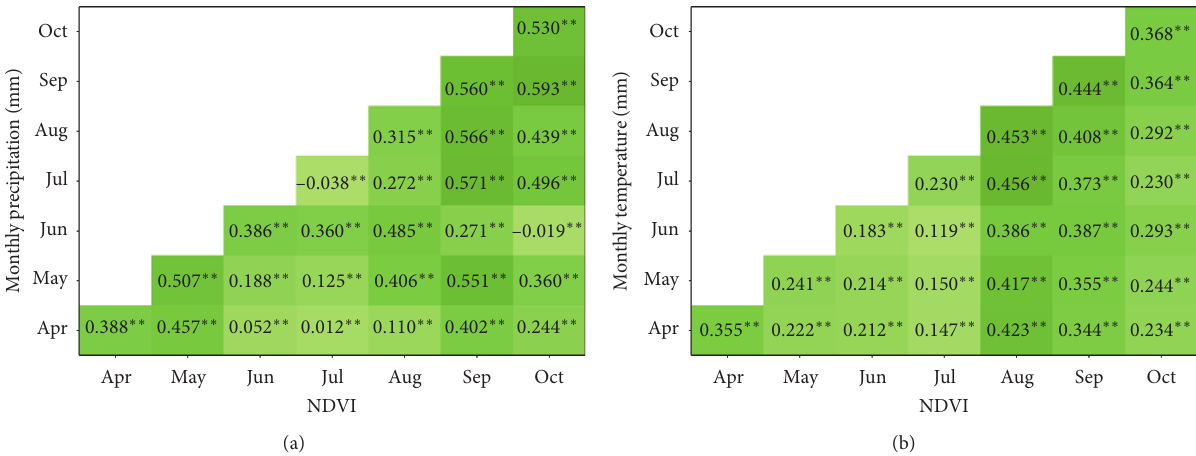
Figure 12: Correlation between monthly NDVI and climatic variables from all previous months from 2001 to 2018. ∗ and ∗∗ indicate P < 0 . 01 and P < 0 . 05,